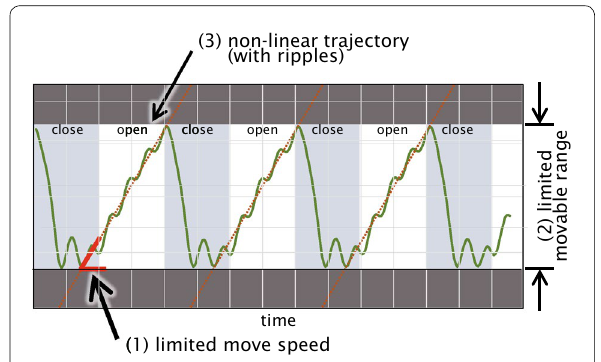
Fig. 3 Constraints of high-frequency response actuator